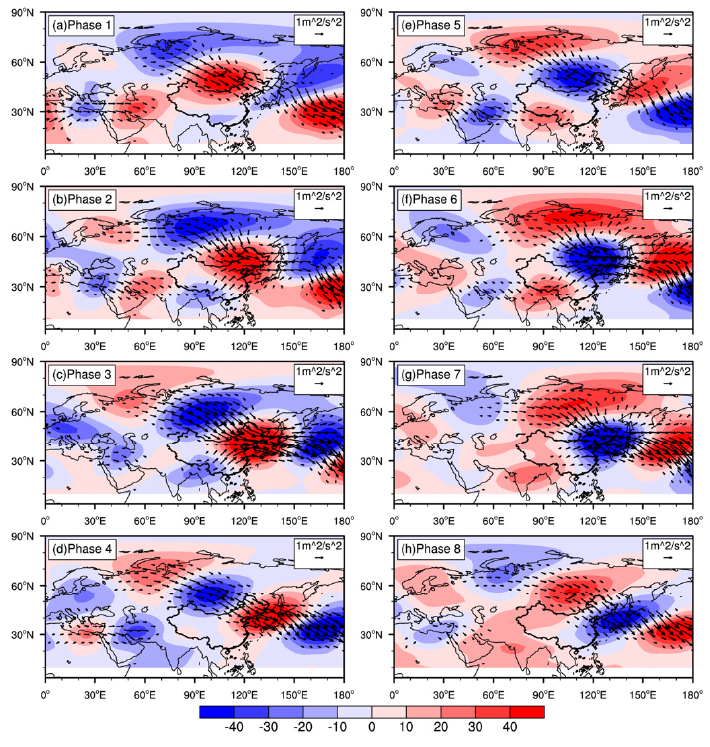
Figure 7. Phase evolution of 10–30 d filtered 200 hPa T-N wave activity flux (vector; unit: m 2 /s 2 ; values less than 0.3 m 2 /s 2 are masked) and quasi-geostrophic perturbation stream-function (shading; unit: 10 − 5 m 2 /s) of LECEs.